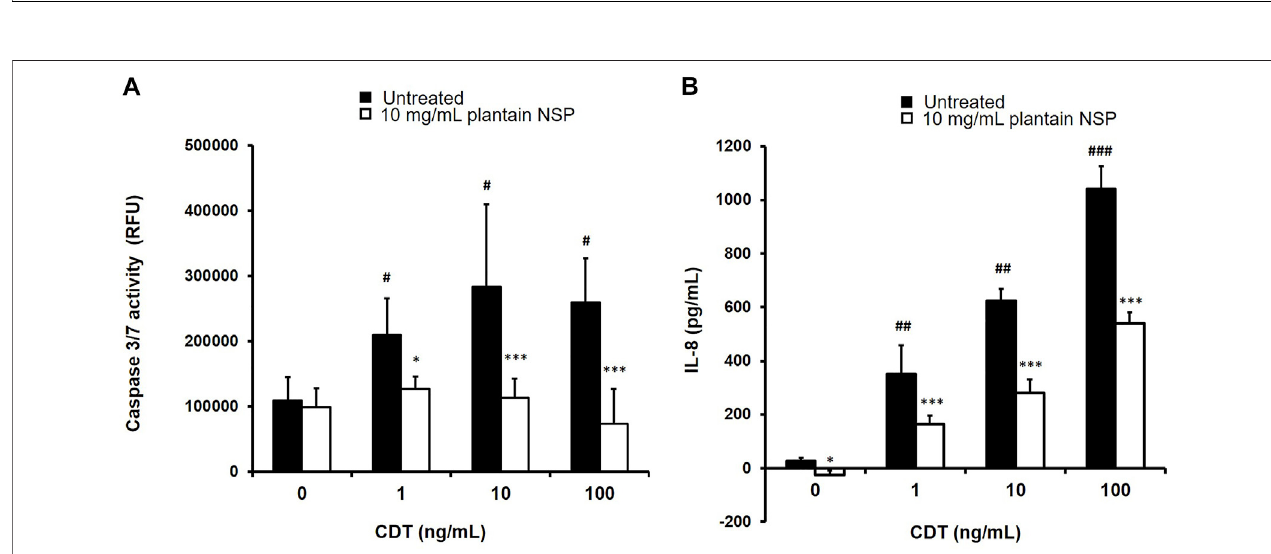
FIGURE 8 | Soluble NSP from plantain counters the pathogenic actions of C. dif fi cile binary toxin (CDT) on human colonocytes. Treatment of the SW480 colonic cell-line with C. dif fi cile binary toxin (CDT, 1 – 100 ng/ml for 24 h) resulted in dose-dependent induction of (A) apoptosis and (B) in fl ammation, which was signi fi cantly attenuatedwithplantainNSPpre-treatment(at10 mg/mlfor30 min).Apoptosiswasassessedbycaspase3/7Gloassay(RFU,relative fl uorescenceemissionunits),and pro-in fl ammatory cytokine IL-8 secreted to culture medium was assessed by ELISA. Data expressed as mean ± SD. Signi fi cant differences of toxin-treated cells from untreated controls; # p < 0.05, ## p < 0.01, ### p < 0.001 and between plantain NSP and vehicle pre-treated cells, * p < 0.05, ** p < 0.01, *** p < 0.001; Kruskal-Wallis test; N (cid:2) 2 experiments, n (cid:2) 3